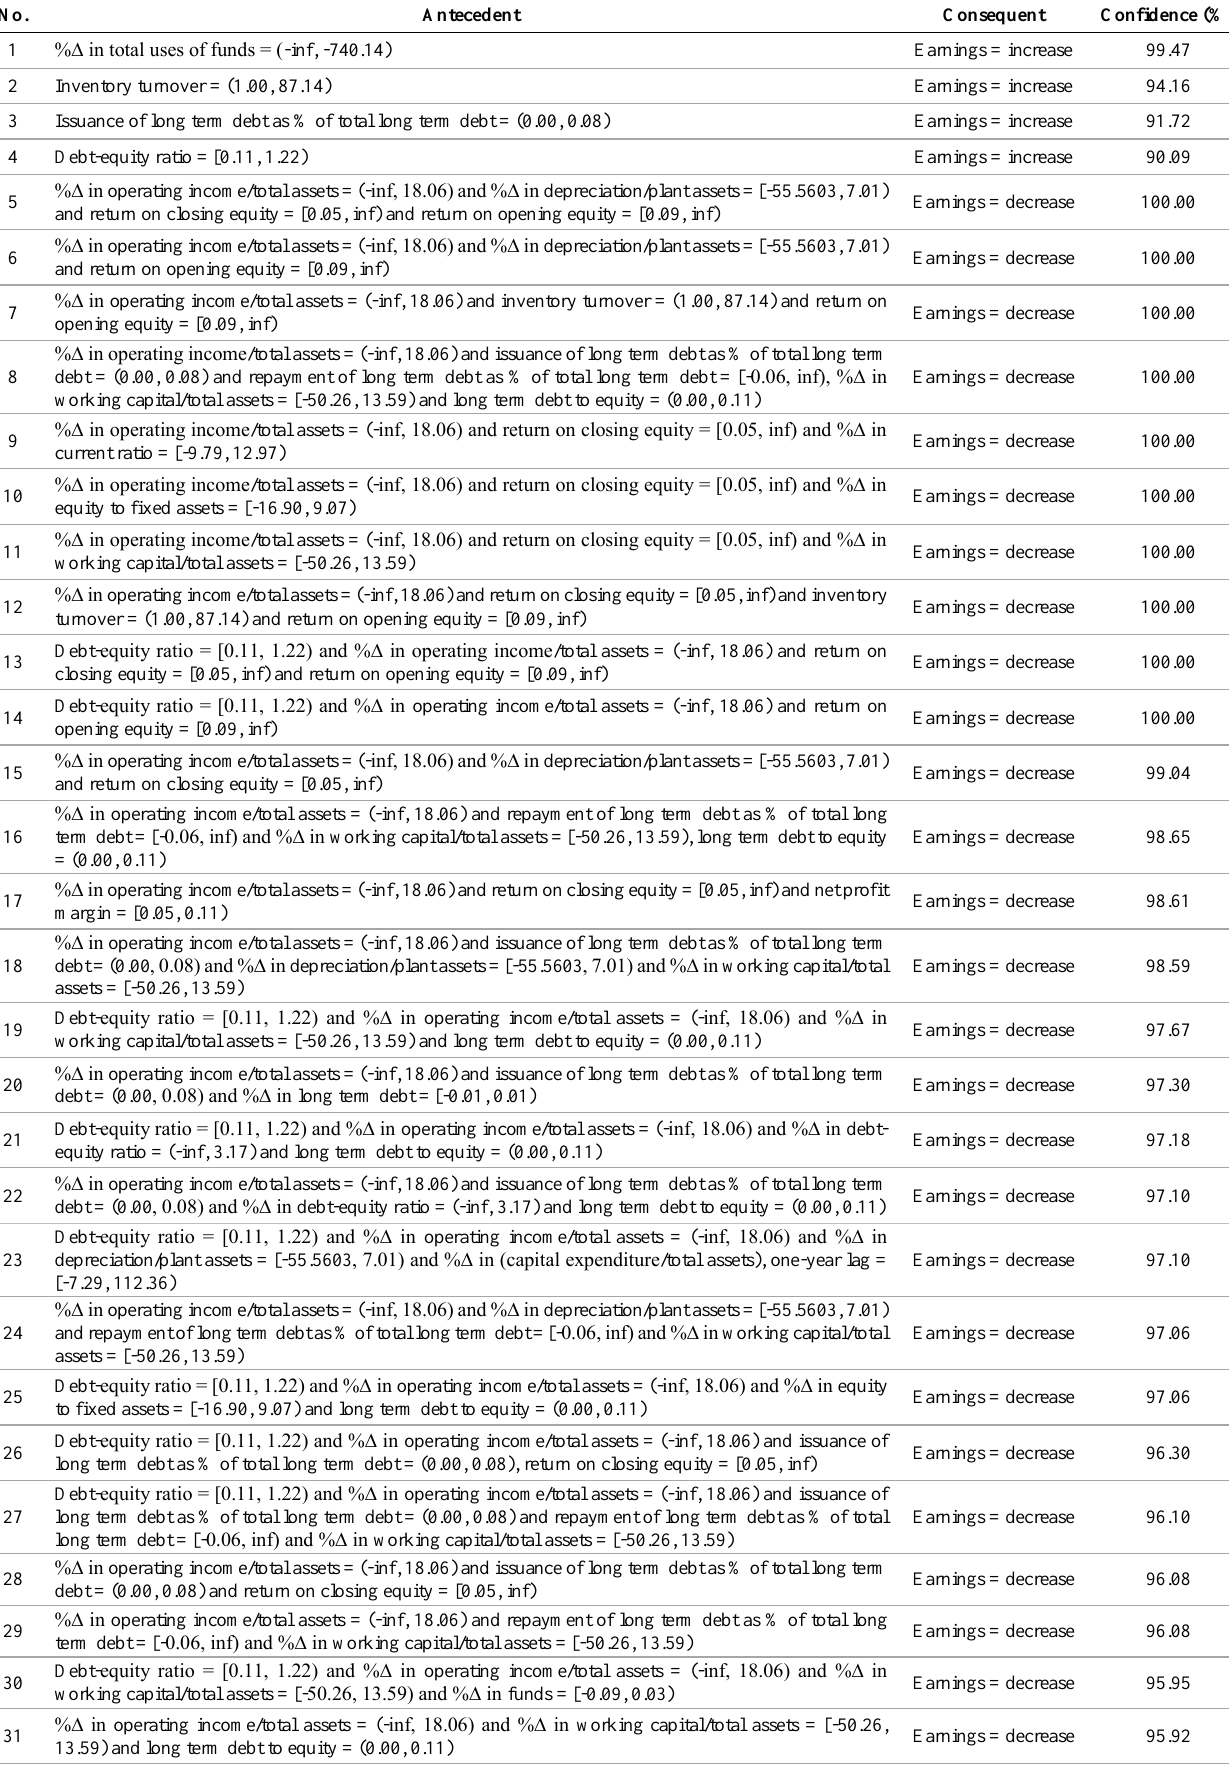
Table 6. Associated patterns of earnings derived from